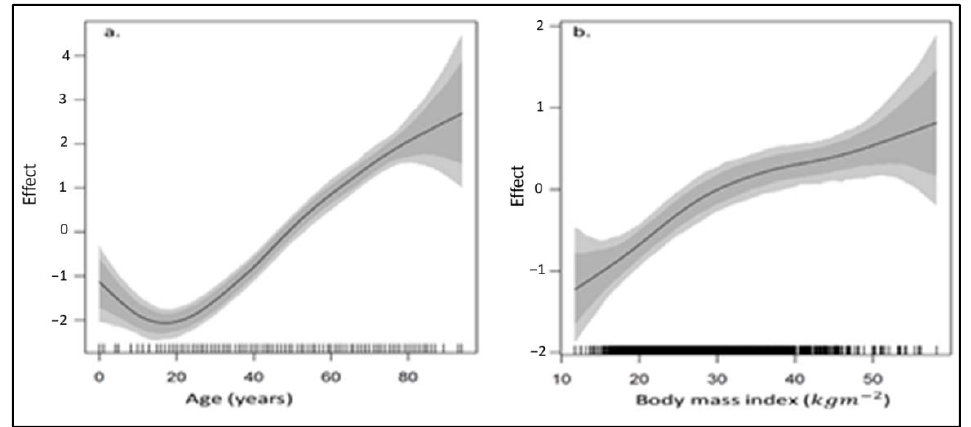
Figure 6. Non-linear smooth function plots of the effects of ( a ) age and ( b ) body mass index (BMI) on the prevalence of hypertension in South Africa based on the adjusted model fitted to the 2012 SANHANES dataset.